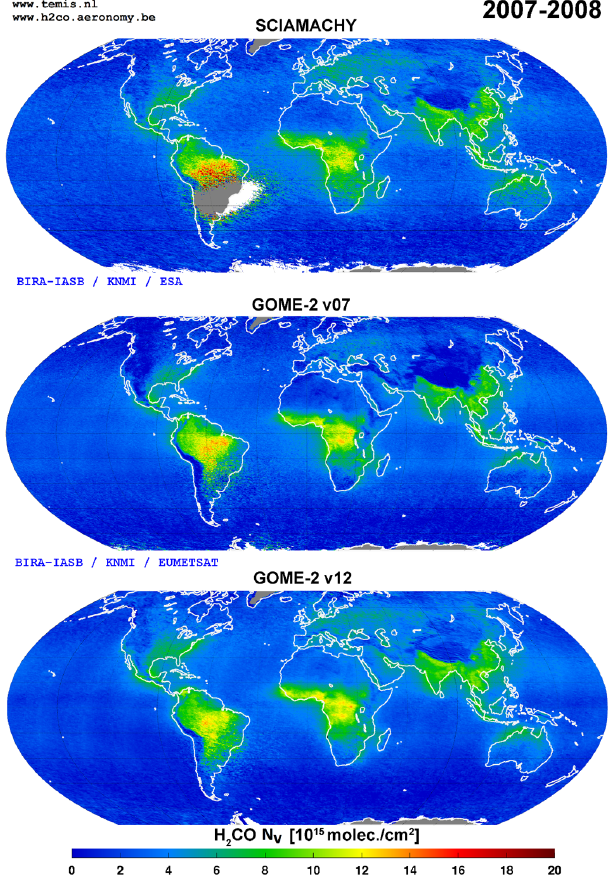
Fig. 1. H 2 CO vertical column retrieved from SCIAMACHY and GOME-2 between 2007 and 2008. The initial retrieval settings used for GOME-2 v07 are based on the GOME and SCIAMACHY set- tings (De Smedt et al., 2008, 2010), while v12 includes the im- proved retrieval settings developed for GOME-2 (see text for de-